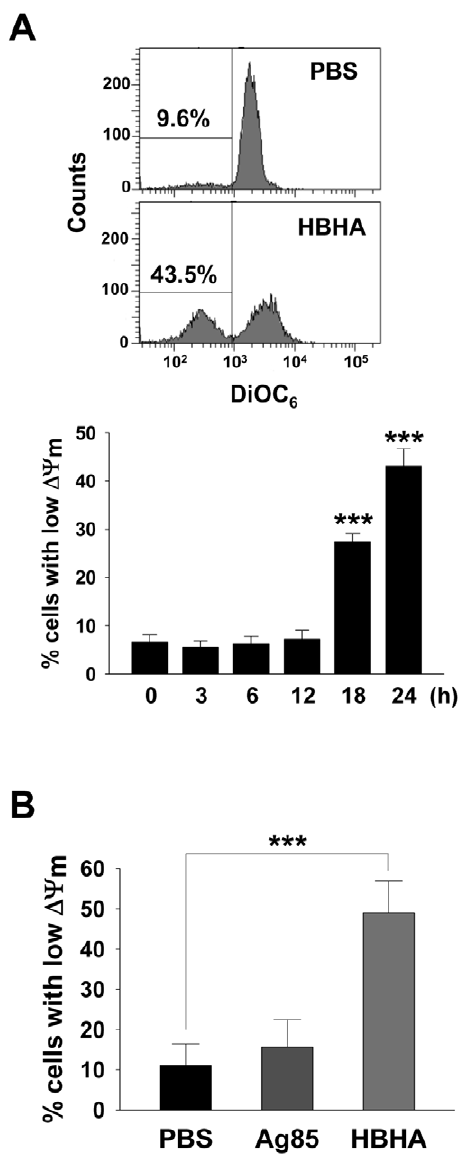
Figure 2. HBHA-induced the loss of DY m in macrophages. RAW 264.7 cells (A) or BMDMs (B) were incubated with PBS, Ag85 (5 m g/mL), or HBHA (5 m g/mL) for the indicated time periods (A) or 24 h (B). Cells were washed and stained with DiOC 6 (40 nM). The fluorescence activity of DiOC 6 was determined by flow cytometry as described in the Materials and Methods. A shift in the cell population to the left indicates a loss of DY m . Histograms shown are representative of at least three independent experiments. Mean 6 SD of three independent experi- ments is shown. *** P , 0.001 cells treated with PBS versus those treated with